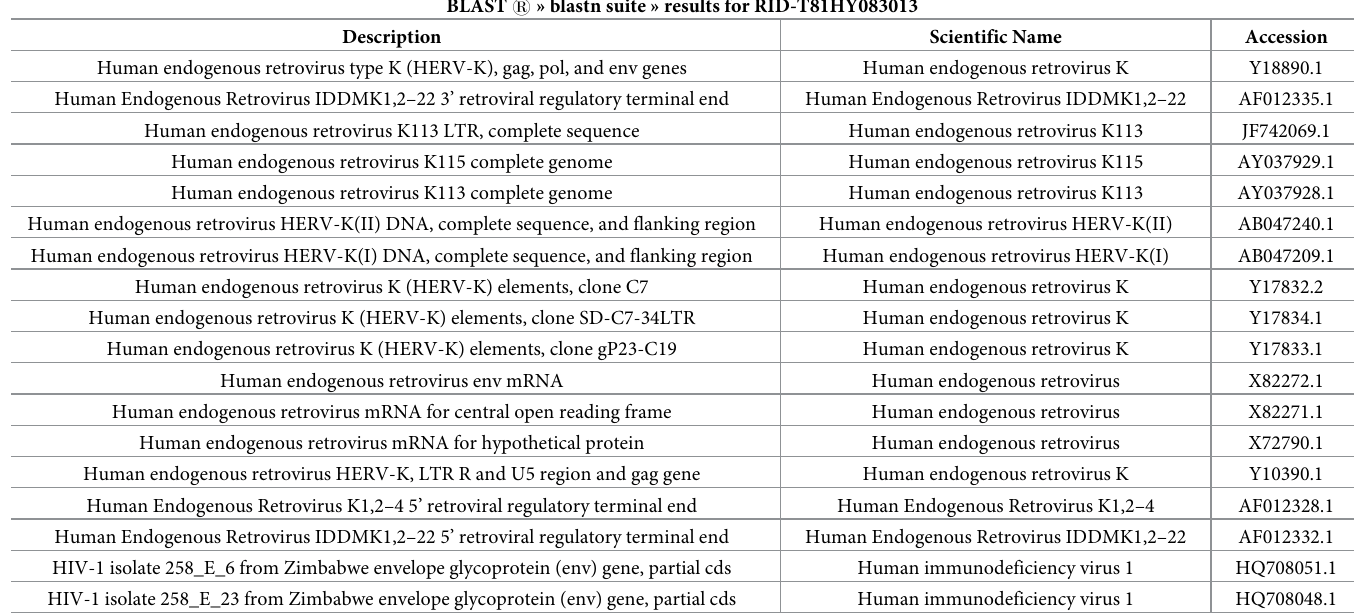
Table 3. Viral identities found in the promoter region amplified product of NSC and CD133 + GBM gDNA. Standard BLAST of 493 nucleotide-long “Promoter” region revealed that only 275 nucleotides have identities to retroviral sequences, including